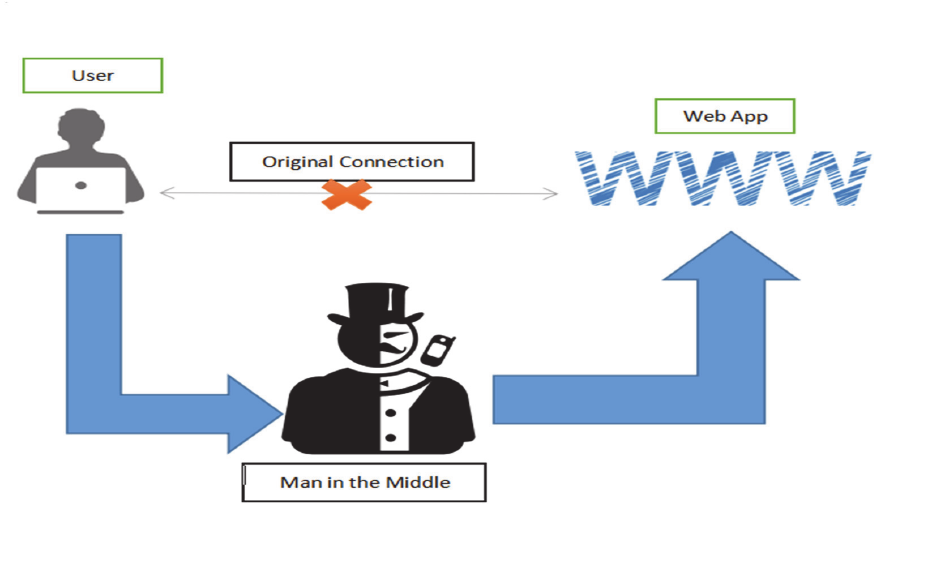
Fig. 1. Men-in-the-middle attack ideology